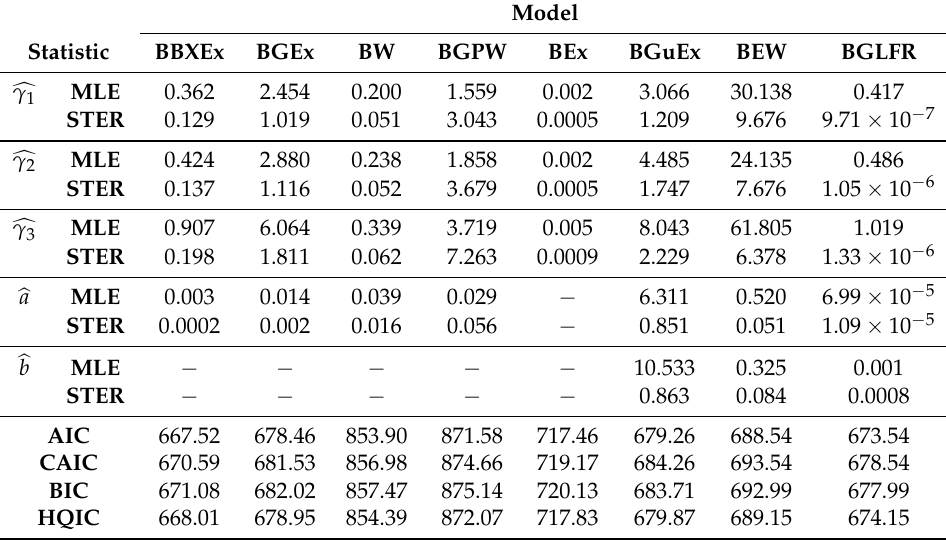
Table 13. The MLE and goodness-of-fit measures based on data set II.